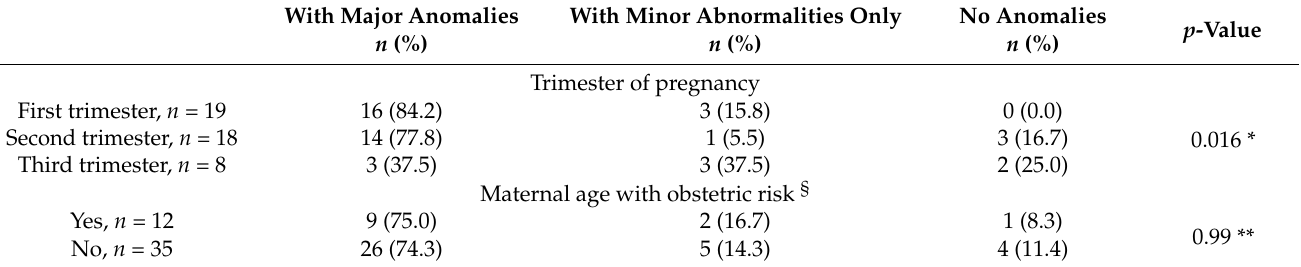
Table 2. Cumulative incidence of anomalies according to trimester of pregnancy and maternal age at the time of ZIKV infection.